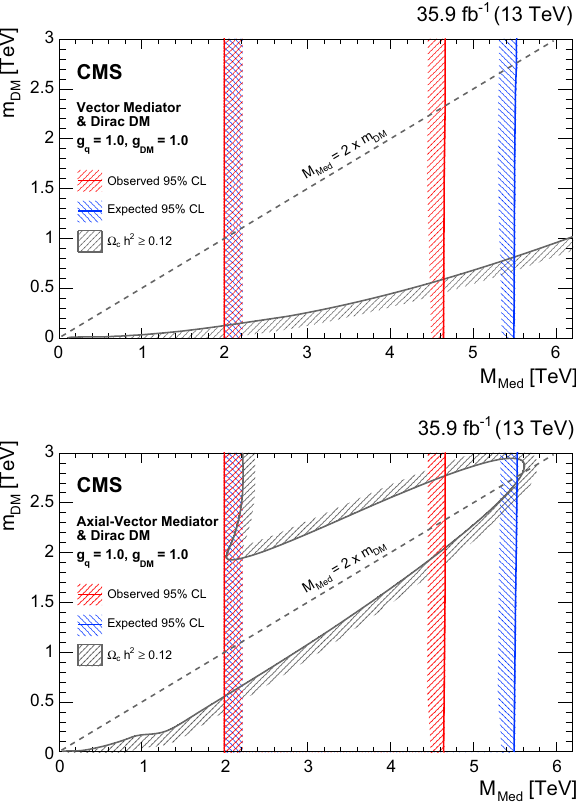
search excludes couplings 1 . 0 ≤ g q ≤ 1 . 4, which are not accessible via dijet resonance searches.